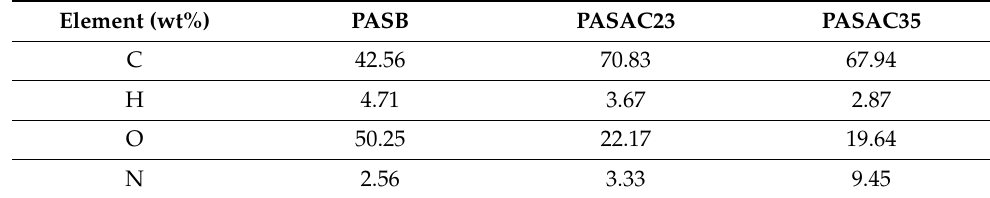
Table 1. Elemental components (wt%) of PASB and PASACs.